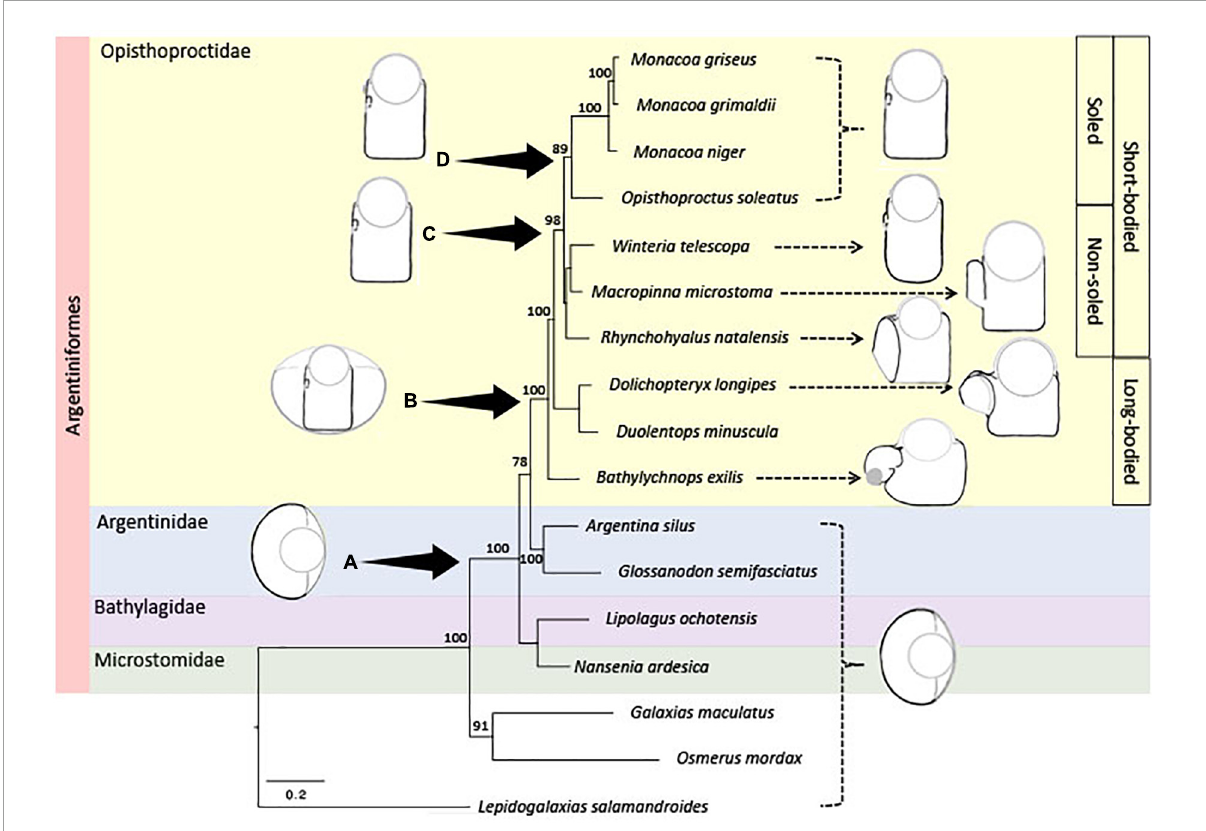
FIGURE9 Maximum-likelihood phylogeny of Opisthoproctidae: This is based on 15 mtDNA and 4 nuclear loci. Numbers on branches indicate percentage bootstrap support, only values > 70 are shown. Nodes A–D represent the common ancestors to all: Argentinifomes (A) , Opisthoproctidae (B) , short-bodied Opisthoproctidae (C) , and sole-bearing Opisthoproctidae (D) , respectively. Duolentops miniscula was previously classified as Dolichopteryx miniscula (Prokofiev, 2020) and Monacoa grimaldi was formerly Opisthoproctus grimaldi (Poulsen et al., 2016). Outlines of the adult eye types of extant species are indicated on the right and the presumed morphology of ancestral species shown on the left. The tube eye shown at node B is superimposed on a more spherical eye to illustrate how a tubular eye is equivalent to a peripherally reduced spherical one (Locket, 1977). The scale bar represents a measure of genetic